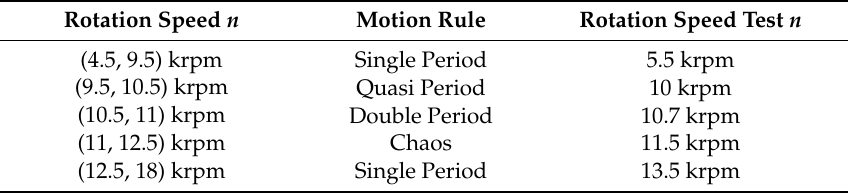
Table 3. Rotor Motion with different Rotation Speed.